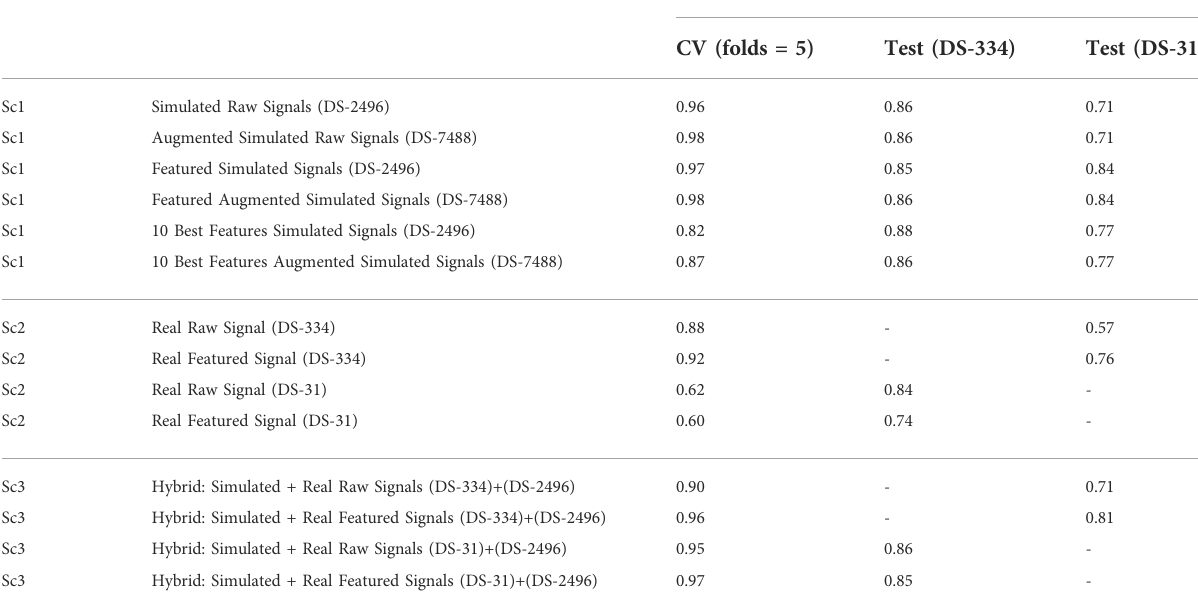
TABLE 2 SVM accuracy